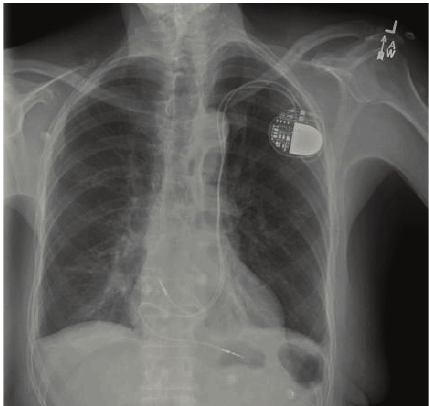
Figure 2: Chest X-ray showing postprocedure implantation of a dual chamber pacemaker, with leads traversing through a persistent left superior vena cava.